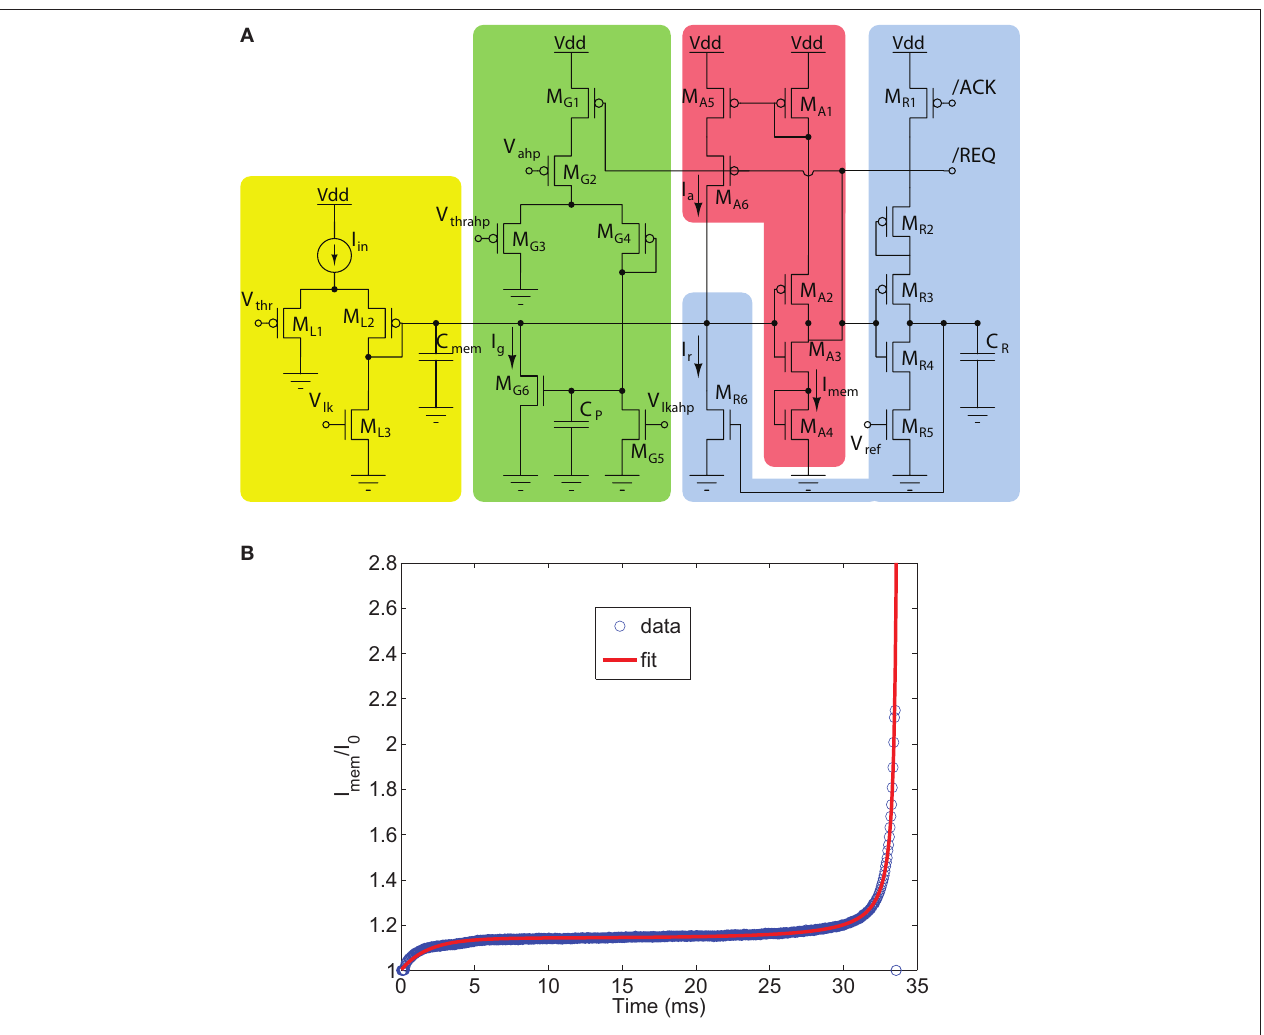
FIgure 14 | The DpI neuron circuit. (a) Circuit schematic. The input DPI low-pass filter (yellow, M ) models the neuron’s leak conductance. A spike − M L1 L3 event generation amplifier (red, M ) implements current-based positive − M A1 A6 feedback (modeling both sodium activation and inactivation conductances) and produces address-events at extremely low-power. The reset block (blue, M ) resets the neuron and keeps it in a reset state for a refractory period, − M R1 R6 set by the V bias voltage. An additional DPI filter integrates the spikes ref